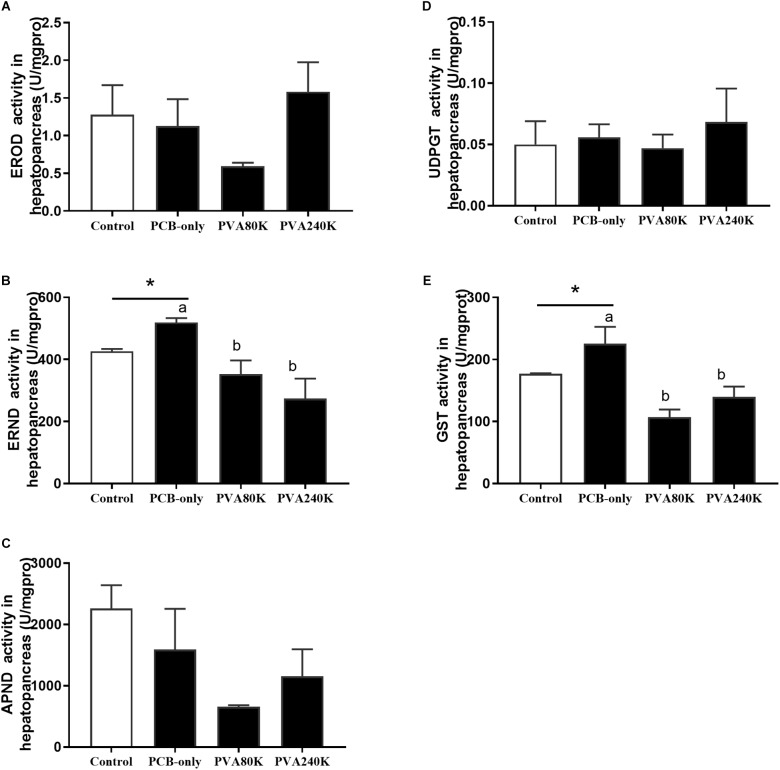
Effects of the vitamin A on the Aroclor 1254-mediated activities of phase I detoxication enzymes: ethoxyresorufin-O-deethylas (EROD) (A), erythromycin N-demethylase (ERND) (B), aminopyrine N-demethylase (APND) (C) and phase II detoxication enzymes, uridine 5′-diphospho-glucur-onosyltransferase (UDPGT) (D) and glutathione S-transferase (GST) (E) of hepatopancreas from three individuals (n = 3); blank bar (diet without PCB), dark bar (diets with PCB). ∗p < 0.05. Data shown as means ± SEM.